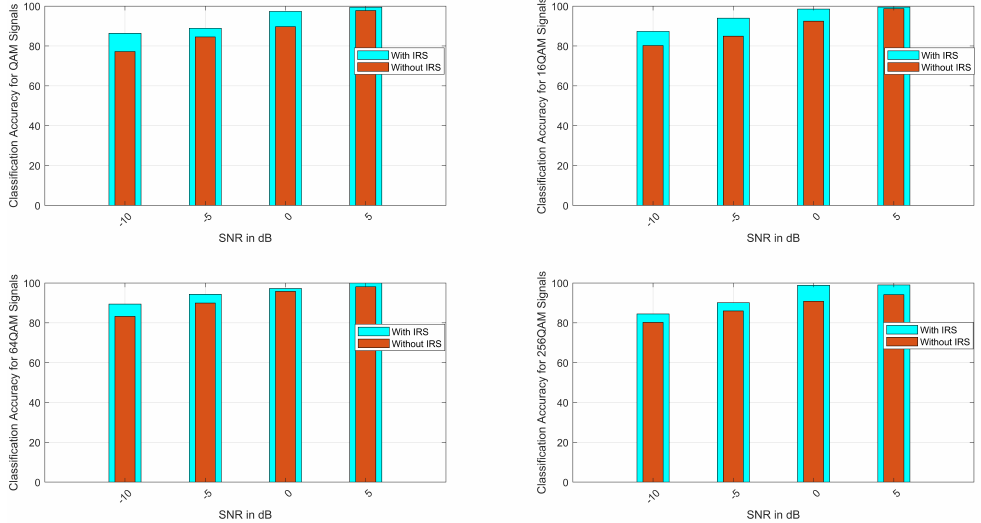
Figure 4. Average classification accuracy for M-QAM signals (QAM, 16-QAM, 64-QAM, and